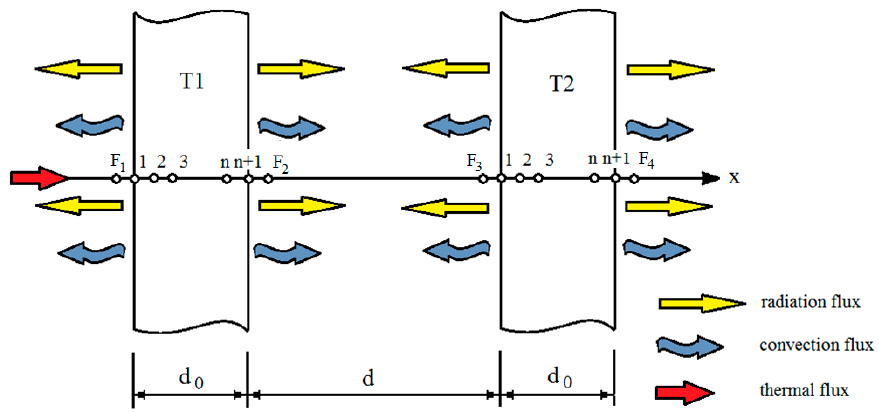
Figure 9. Discretization with nodes for the second experiment. The boundary condition on the left side of shield 1 was similar to Equation (18), the only change being the notation ( T is replaced by T 1) and the law of variation of heat flux over time: The boundary condition on the right side of shield 2 is similar to Equation (20), except the notation, T , was replaced by T 2 and